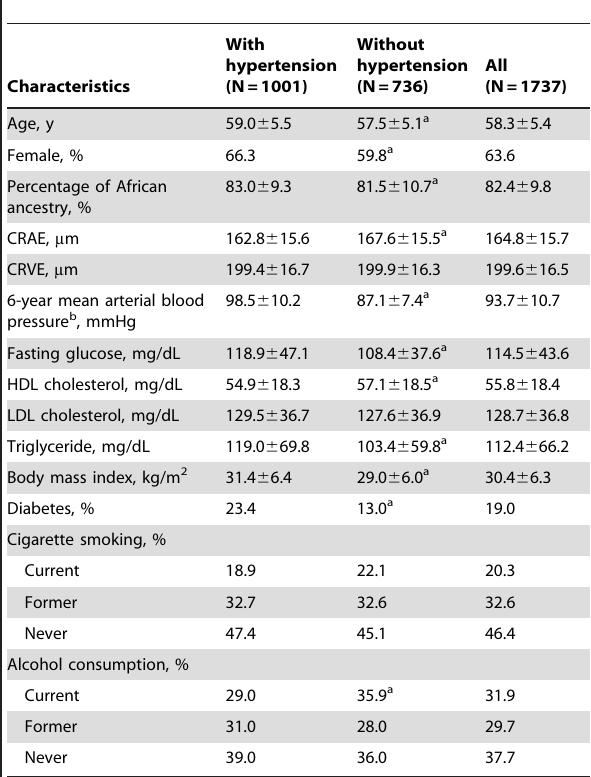
Table 1. Characteristics of the study participants by hypertension